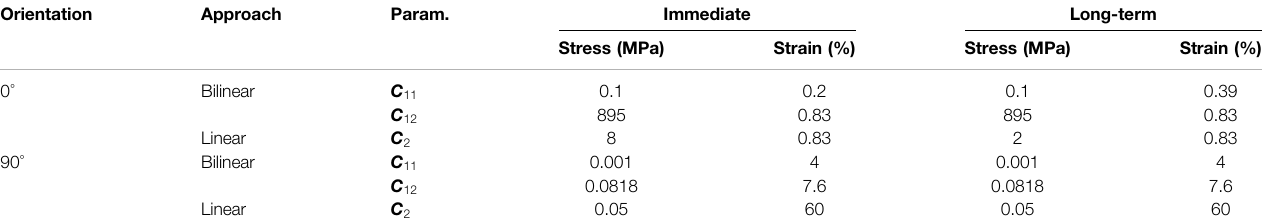
TABLE 3 | Input values to describe the bending properties for the bilinear and linear modeling approach (cf., Figure 2 ). The immediate and long-term responses for the 90 ° orientation are identical. Orientation Approach Param.